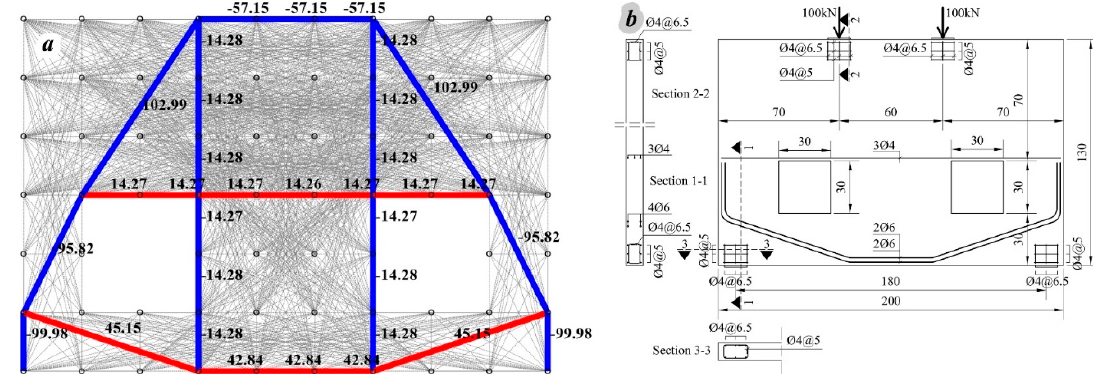
Figure 6. ( a ) Strut-and-Tie model for W1, ( b ) reinforcement layout.